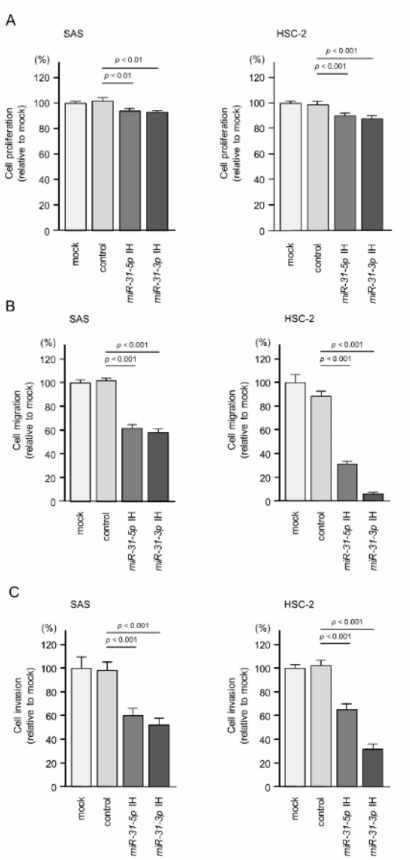
Figure 2. Functional assays of miR-31-5p and miR-31-3p in HNSCC cell lines (SAS and HSC-2). ( A ) Cell proliferation was assessed using XTT assays at 72 h after the inhibitor transfection. ( B ) Cell migration was assessed using a membrane culture system at 48 h after seeding the inhibitor-transfected cells into the chambers. ( C ) Cell invasion was determined using Matrigel invasion assays at 48 h after seeding the inhibitor-transfected cells into the